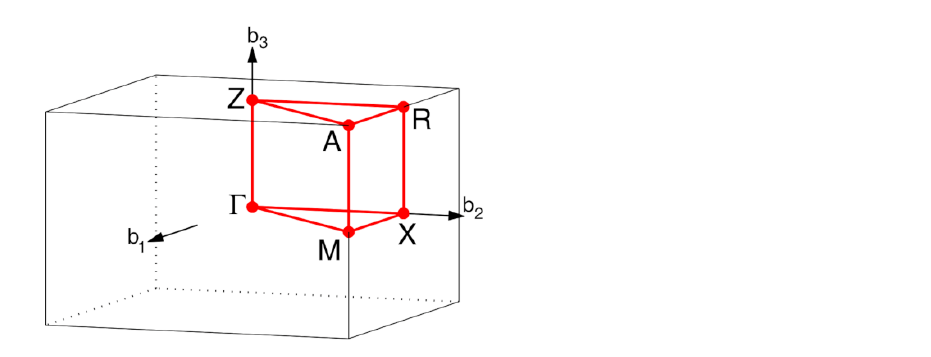
Figure 1. Brillouin zone path G ‐ X ‐ M ‐ G ‐ Z ‐ R ‐ A ‐ Z[X ‐ R]M ‐ A for tetragonal crystals. Reproduced from ref. [25], with permission from Elsevier.